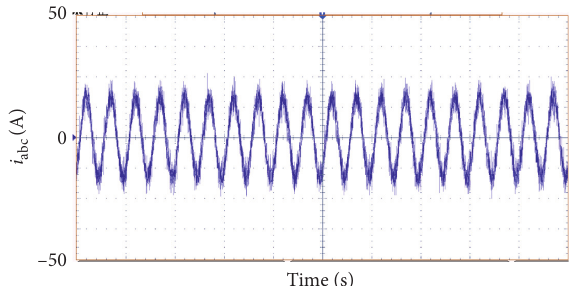
Figure 15: Experimental current waveform of the ESS (output power is set to 10kW).